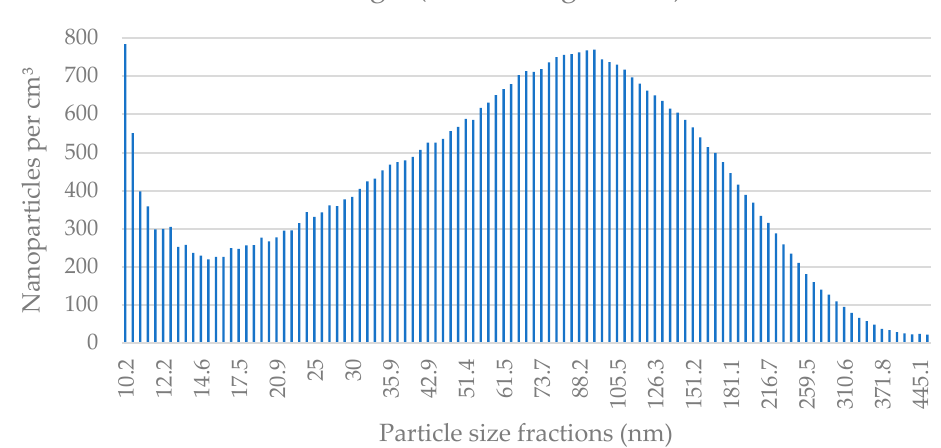
Figure A8. The average nanoparticle concentration in each size fraction in Building 4 during a one-week measurement period during the nonheating season.